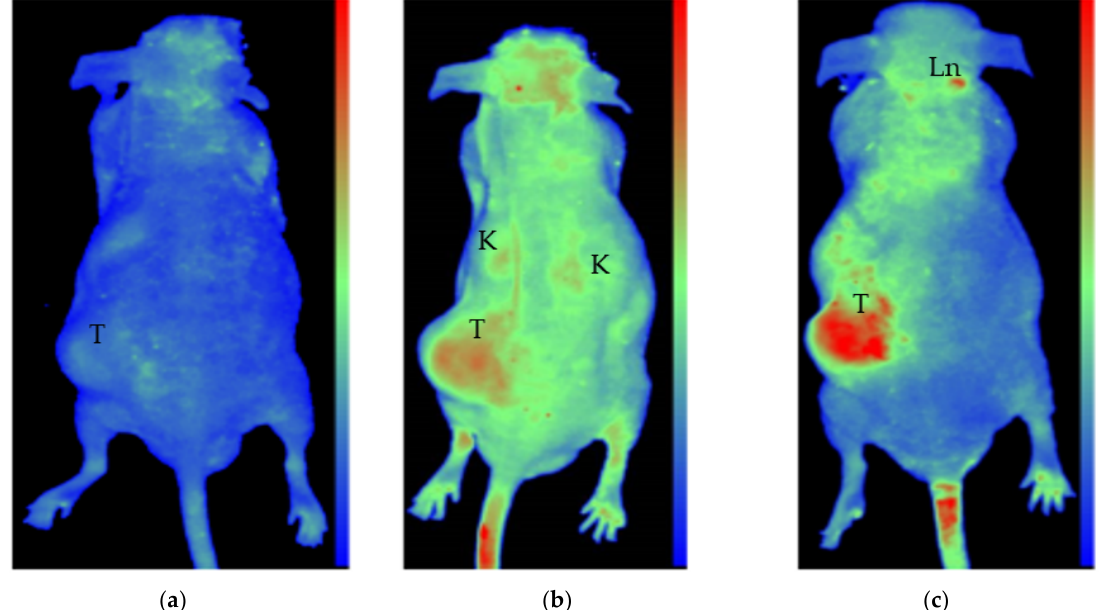
Figure 6. In vivo fluorescent images from the dorsal view of Foxn Nu/Nu nude mice bearing LNCaP prostate xenograft tumors. Images before ( a ) and 24 h after IV ( b ) in one mouse, and after 24 h after intratumoral injection in another mouse ( c ). All images are standardized to identical light radiance minima and maxima in relative light intensity per pixel arbitrary units to allow for direct comparison. Fluorescence of the PDC is identified in the tumor (T) tail vein, kidneys (K), and capillary-rich head nuchal skin in ( b ), while a distinct fluorescent signal is observed in the tumor (T) and some lymph nodes of the neck (Ln) in the case of intratumoral PDC injected animal ( c ). The slight autofluorescence, as seen in (a) before injection, is clearly different from the fluorescent signals of injected animals.